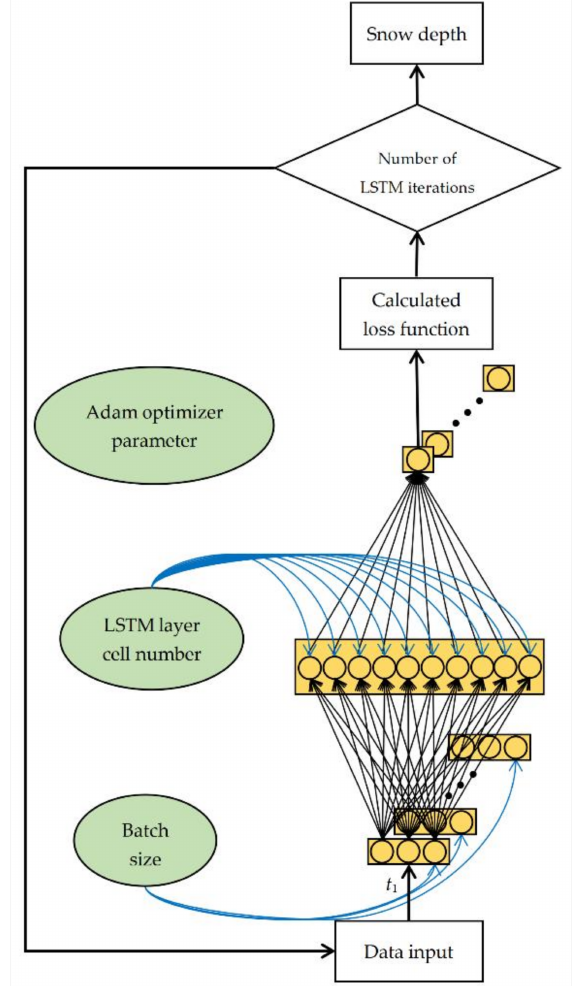
Figure 4. Framework of the LSTM model.